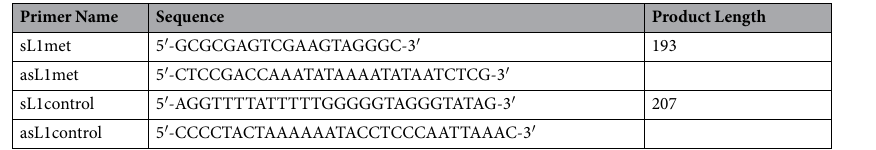
Table 3. Primers used for LINE-1 real time Methylation-Specific PCR.